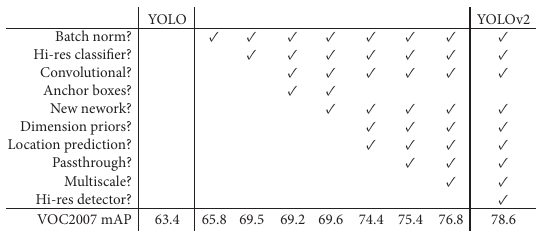
Figure 3: mAP of YOLOv2 at each added part